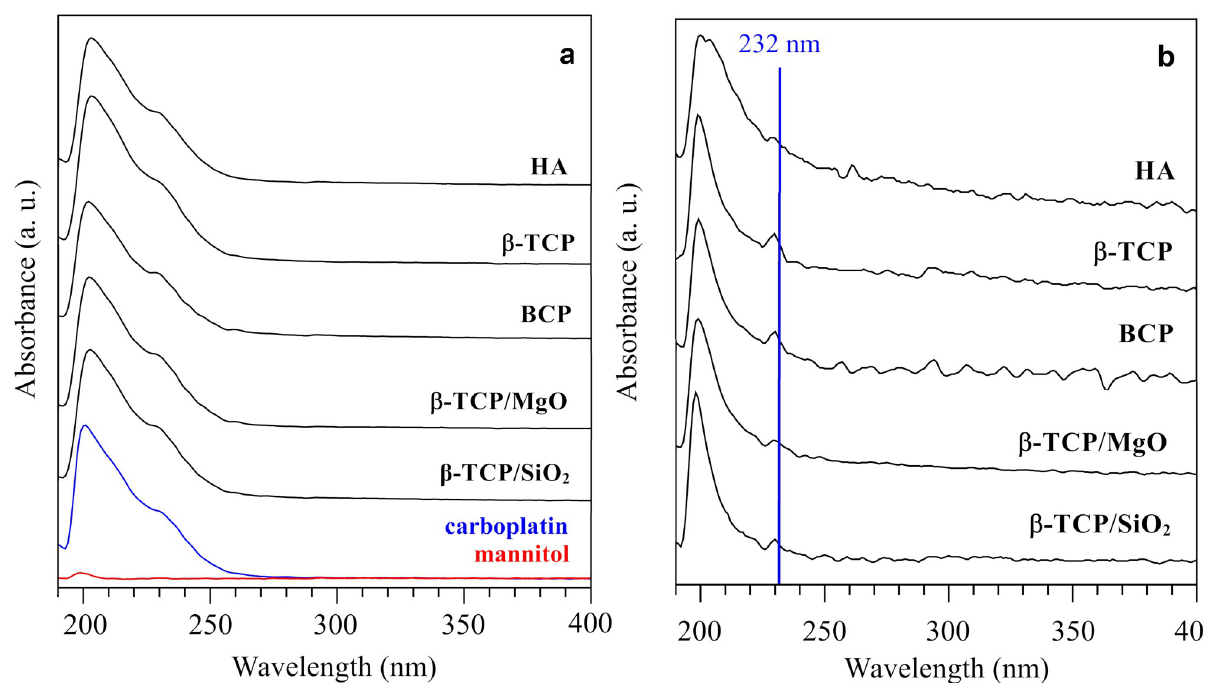
Fig 7. Ultraviolet-visible (UV-Vis) spectroscopy analysis of release medium and blank tests. (a) UV-Vis spectra of 60 minutes-release solution; 50 μ g/mL carboplatin-drug (carboplatin and mannitol) solution (blue line), and 50 μ g/mL mannitol solution alone (red line); (b) UV-Vis spectra of blank analysis with only biomaterials and blue line at 232 nm. Absorbance scales in Fig 7A and 7B are not the same. https://doi.org/10.1371/journal.pone.0242565.g007 after 5 hours. However, CaP composition did not show any influence on the rate of carboplatin release. The release behavior was more influenced by the doses previously loaded than the char- acteristics of the biomaterials. The amount of carboplatin released in the medium from 250 mg of the biomaterials was related to the previous doses loaded. The initial release was upon 8 mg (21.5 μ mol) for 50 mg/g and 60 mg/g biomaterials-carboplatin and 10 mg (27 μ mol) for 70 mg/ g dose (S6 Fig). The pH measured after the release study was 7.4 ± 0.1 at 37˚C. Table 3. Remaining weight of the CaP-carboplatin biomaterials after the load process by the high-vacuum method. Biomaterial Carboplatin